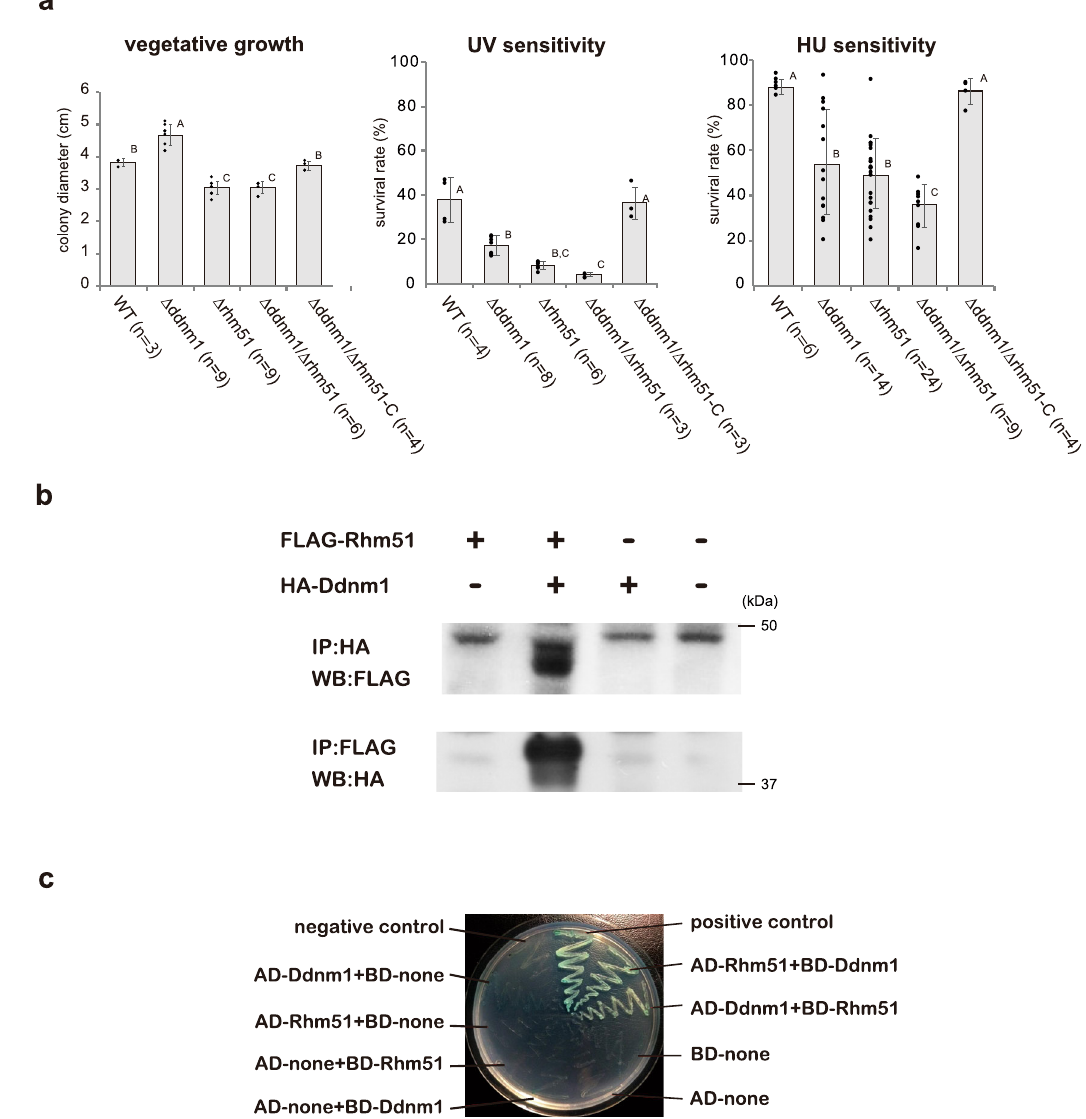
Fig. 2 Ddnm1 interacts with Rhm51 and plays a role in tolerance to DNA-damaging agents. a Phenotypic characterization of Δ ddnm1, Δ rhm51 and Δ ddnm1/ Δ rhm51 mutants ( Δ 11350-22), and a gene complementation strain ( Δ ddnm1/ Δ rhm51-C). For growth assay, colony diameter was measured after 5 days of culture at 26 °C. Sensitivity to DNA-damaging agents (UV and hydroxyurea [HU]) were examined as described in Methods. Each bar represents the average of three or six replicates (±SE). Different letters denote statistically signi fi cant differences (Tukey – Kramer HSD test, P < 0.05). b Co- immunoprecipitation assay of Ddnm1 and Rhm51. Ddnm1 and Rhm1 were tagged with HA and FLAG at the N-terminus, respectively, and introduced into P. oryzae cells by the transformation. Cell lysates were immunoprecipitated (IP) with anti-HA or anti-FLAG antibodies, followed by western blotting (WB) with an anti-FLAG or anti-HA antibody. c Yeast two-hybrid assay for the interaction of Ddnm1 and Rhm51 was performed using the constructs pGBKT7-53 with pGADT7-T as positive control and pGBKT7-Lam with pGADT7-T as a negative control. The interaction was veri fi ed by the growth of mated yeast strains on the SD/ – Leu/ – Trp/-Ade/ – His/ + AureobasidinA medium containing X- α contiguous and thus, 10 genomic locations were selected. Among them, three blocks were insertion sites of plasmid vectors such as pMGY- Δ RT in either the wild-type or Δ ddnm1/ Δ rhm51 strain, and four blocks contained endogenous MAGGY-like sequences (Supplementary Table 3), indicating that their different levels of MeDIP mapping were not due to the Δ ddnm1/ Δ rhm51 mutation itself but due to the introduction of pMGY- Δ RT into the transformants. Thus, the results indicated that only very small fractions of the genome were signi fi cantly affected by the Δ ddnm1/ Δ rhm51 mutation, indicating that the Rhm51 – Ddnm1 complex played a role in de novo but not maintenance DNA methylation.